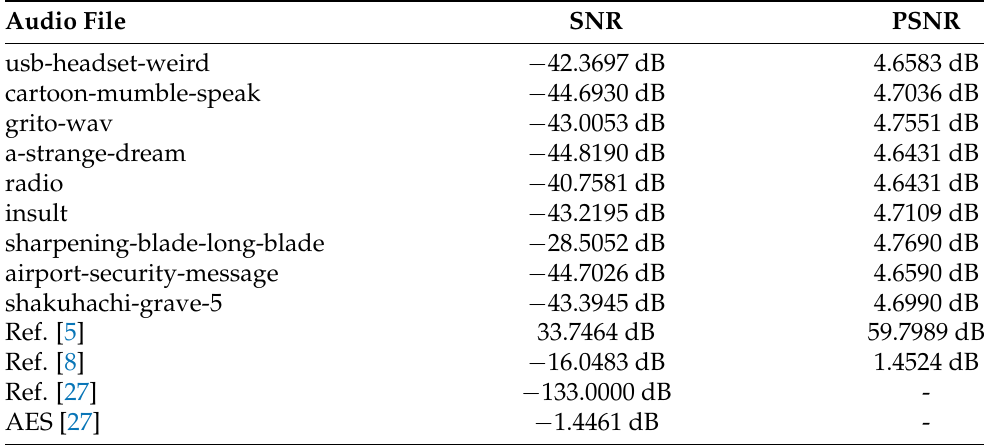
Table 3. Peak signal-to-noise ratio.